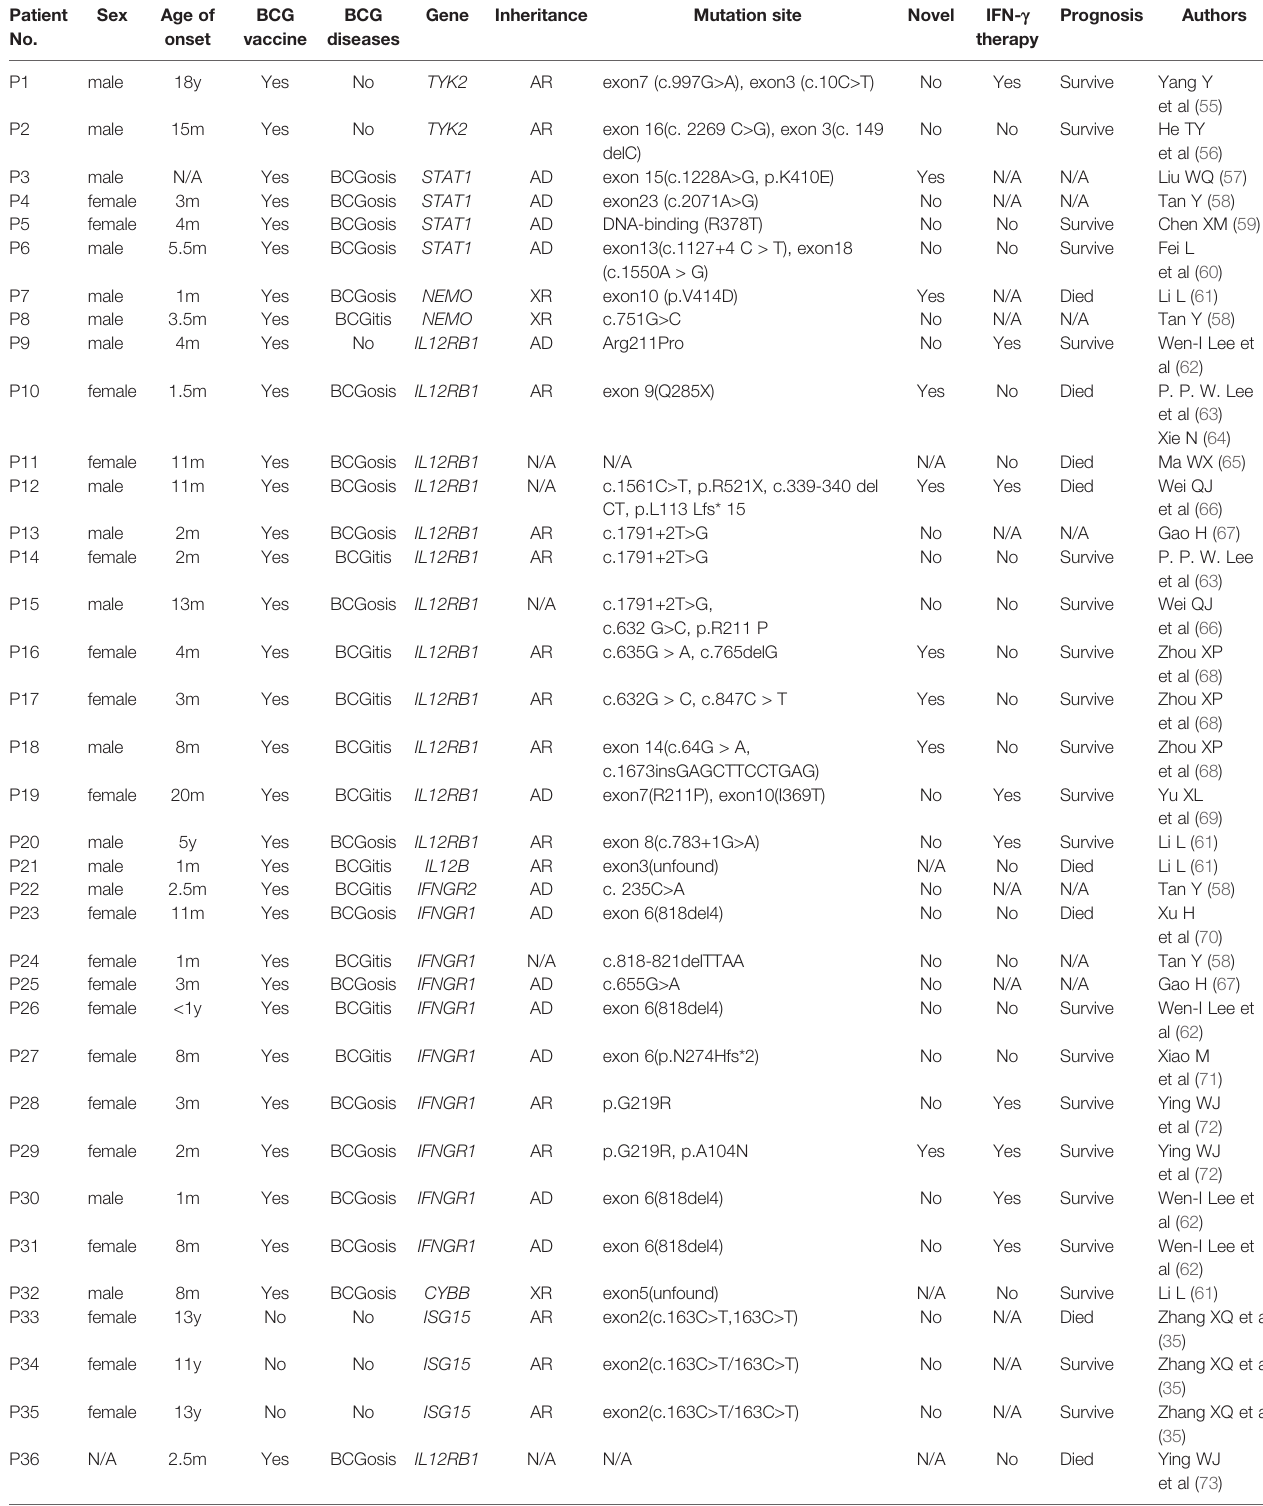
TABLE 2 | Demographic data of the 65 MSMD patients reported in China. Patient